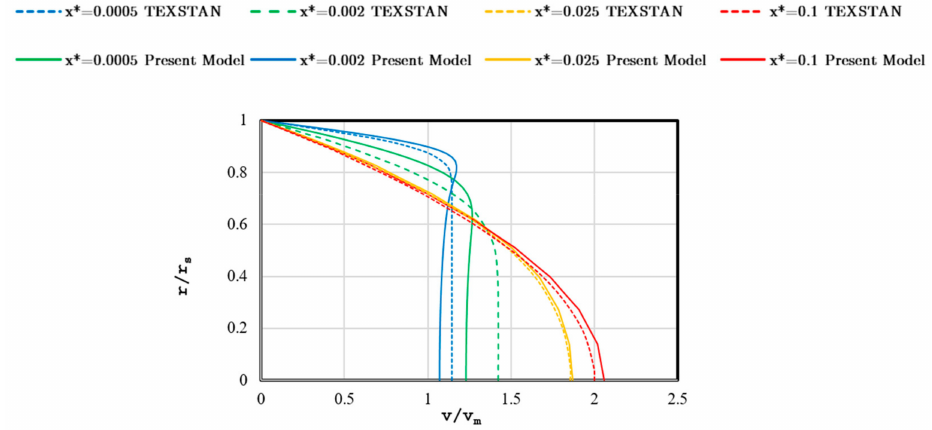
Figure 4. Comparison between TEXSTAN and the present model for velocity profiles at di ff